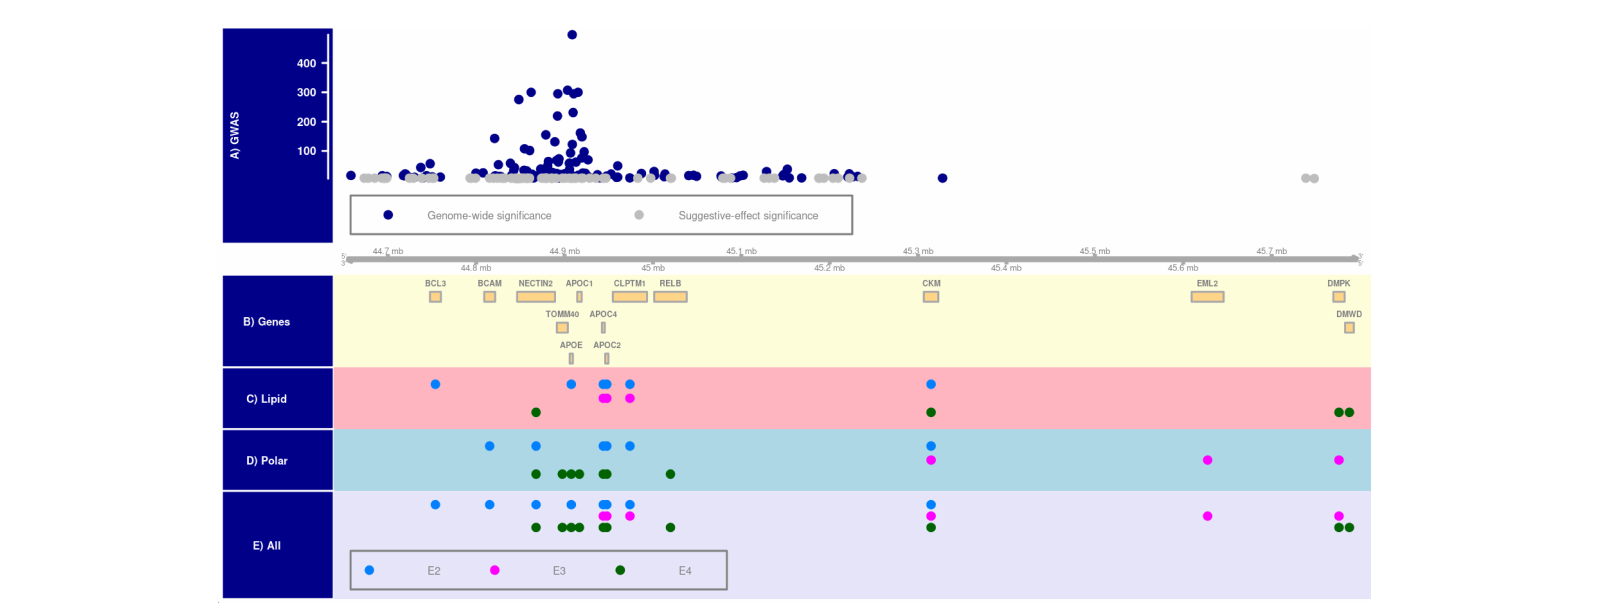
FIGURE1 APOE -allele-specific clustering of genes identified for all metabolites, lipid metabolites, and polar metabolites. Panel (A) shows the distribution of –log ( p -value) of Alzheimer’s disease-associated SNPs at genome-wide (i.e., P < 5E–08) and suggestive-effect (i.e., 5E–08 ≤ P < 5E–06) significance levels in the 19q13.3 region [chromosomal positions are based on Human Genome version 38 (hg38) and shown in mega base-pair format]. Panel (B) shows the location of genes in this locus. Panels (C–E) show metabolite-by-gene associations for polar, lipid, and all metabolites in the E2 ( ε 2 ε 2 and ε 2 ε 3 subjects), E3 ( ε 3 ε 3 subjects), and E4 ( ε 3 ε 4 and ε 4 ε 4 subjects)